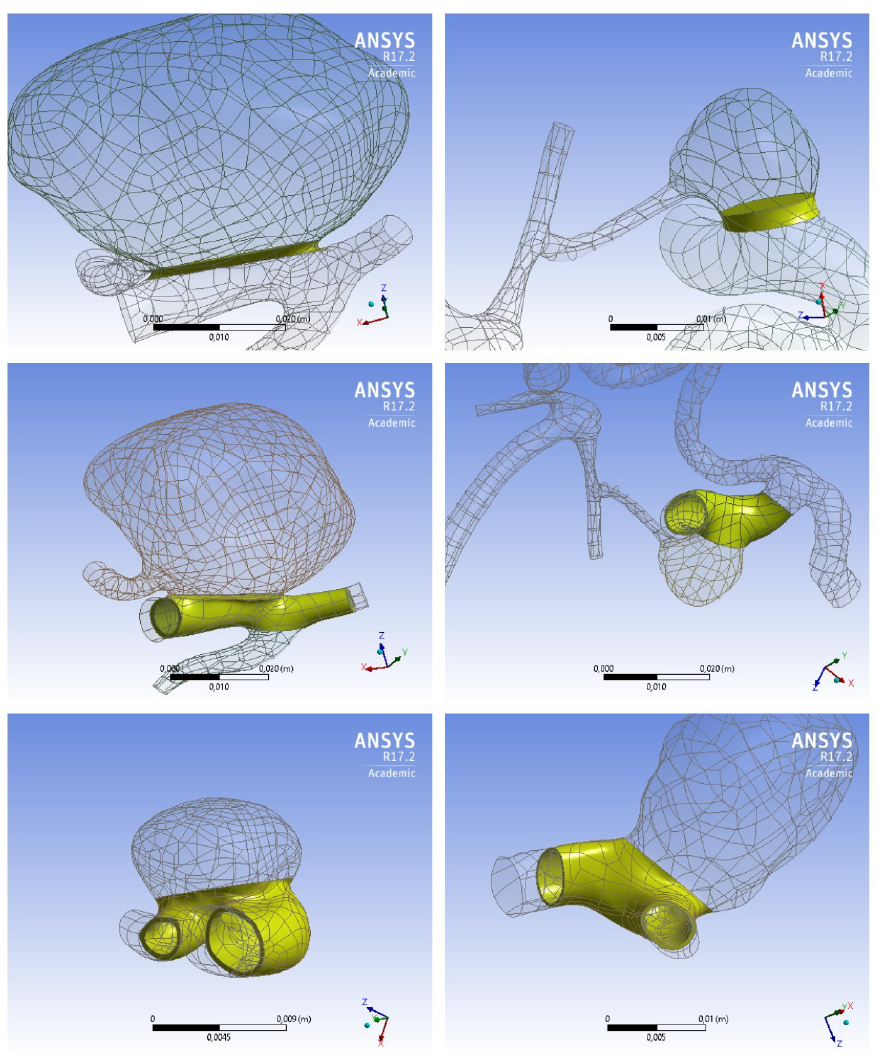
Figure 4. Approaches used to simulate virtual stent placement in cerebral vessels. Top row-scenario 1 like approach: patient 1 (on the left ), patient 2 (on the right ). The technique of the stent-layer between the aneurysm and the maternal vessel is performed as in [40]. Central row-the technique of the stent-tube located in the maternal vessel, performed as in [31] for patients 1 (on the left ) and 2 (on the right ), bottom row-the same stent-tube technique in patients 3 (on the left ) and 4 (on the right